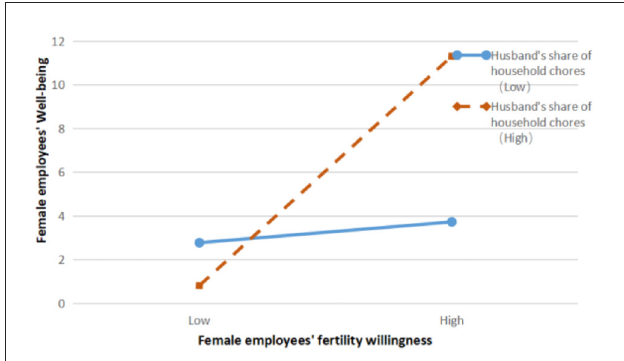
FIGURE4 Moderating effect of husband’s share of housework on the relationship between female employees’ fertility intention and